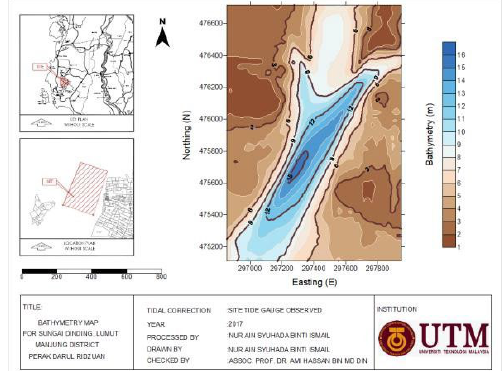
Figure 13. Bathymetric plan relative to the on-site tide gauge in 2017 generated using Surfer